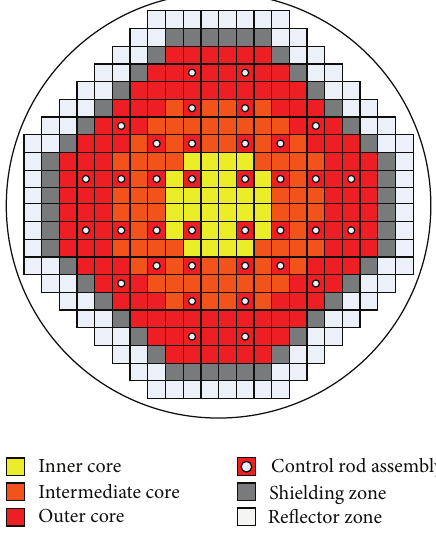
Figure 2: SNCLFR-100 core layout.